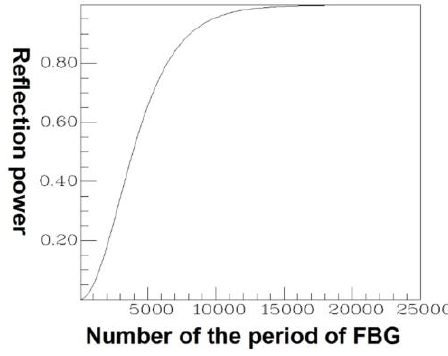
Figure 13. Plot between the FBG period number and the reflection power for the total counterpropagating HE (core mode) with N = 18,000 and Λ = 0.5336803 11